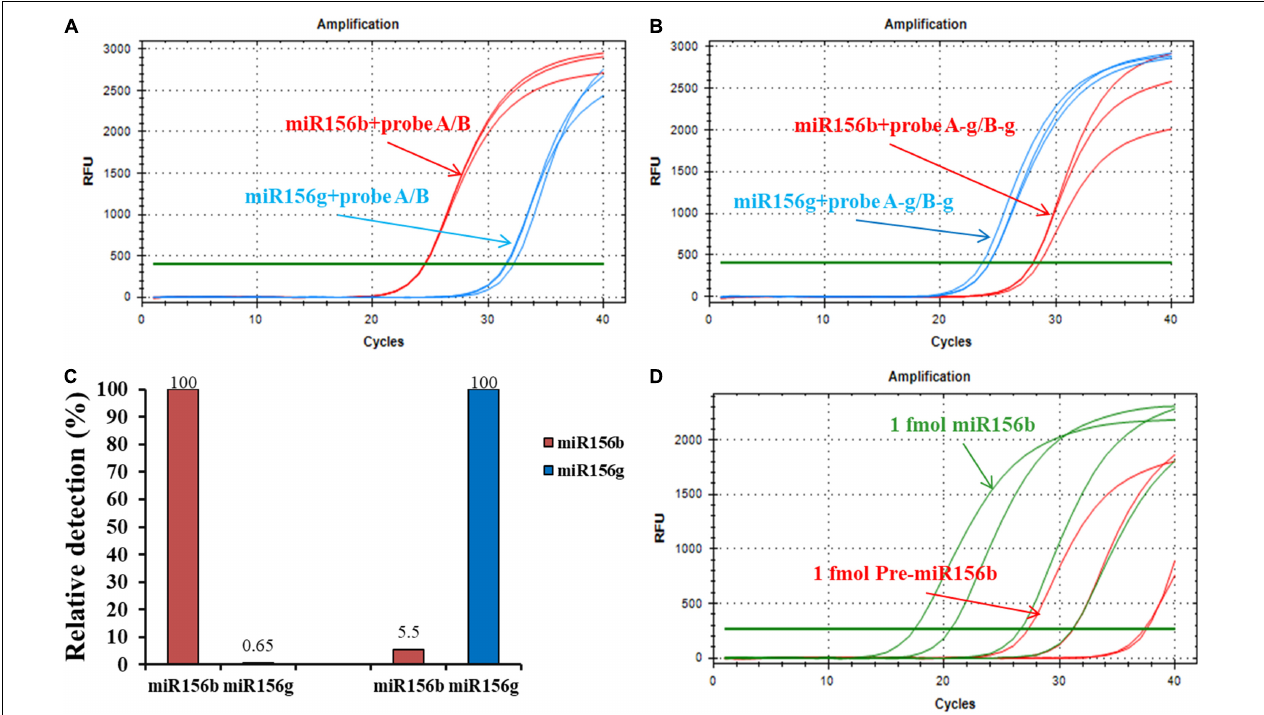
FIGURE 5 | Generality and practicability of the ligation-based assays for detection of different miRNAs. (A) Amplification plot of miR156b and miR156g with probe A/B. (B) Amplification plot of miR156b and miR156g with probe A-g/B-g. (C) Relative detections for miR156b and miR156g with different target miRNAs. (D) Specificity of developed method in distinguishing miRNAs from their corresponding pre-miRNAs. From left to right in red line, the concentrations of synthetic miR156b is 1 fmol, 100 amol, 10 amol, 1 amol; from left to right in green line, the concentrations of synthetic pre-miR156b is 1 fmol, 100 amol, 10 amol, 1